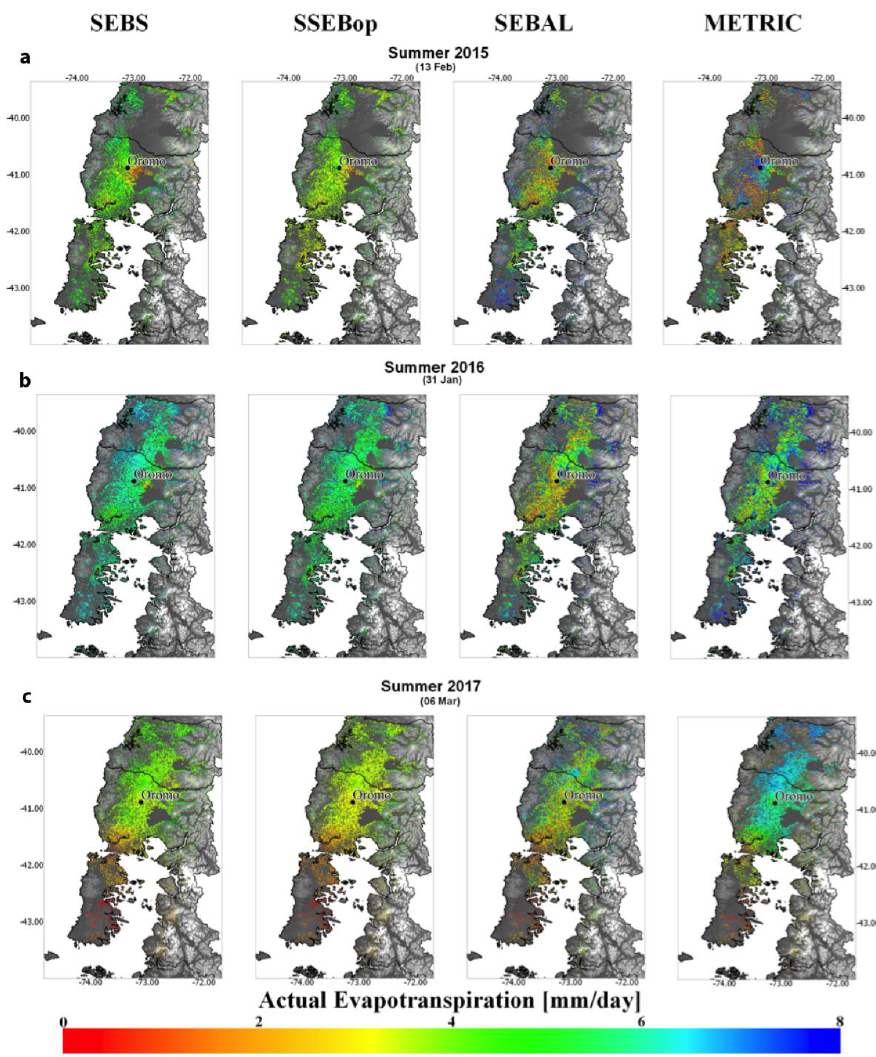
Figure 5. Evapotranspiration estimates and daily surface meteorology at the Oromo calibration site (OCS) between August 2014 and December 2017. ( a ) Comparison of satellite-based and measured daily evapotranspiration. Measured ET c in Oromo (blue line) is compared with estimates by SEB models (points) and GLEAM 3.3b (yellow line), and PML_V2 (turquoise line) products for the nearest pixel to the station. ( b ) Daily rainfall (blue bars) and soil moisture (purple, turquoise lines) in Oromo. ( c ) Net daily radiation (purple) and surface temperature (orange) measured in